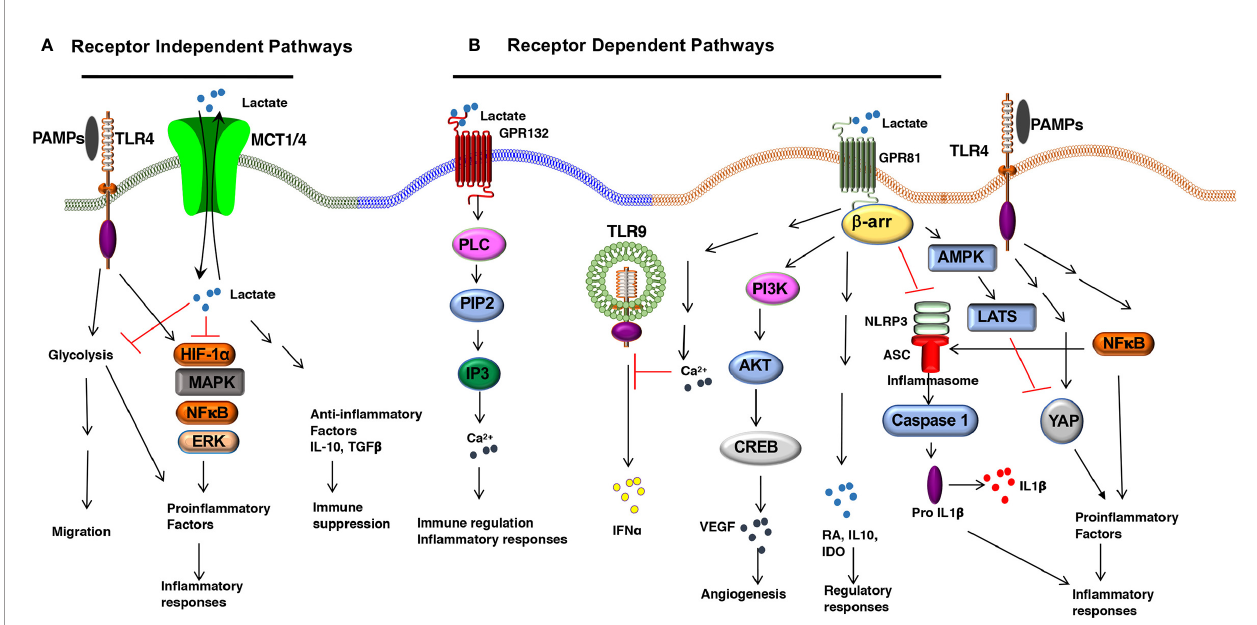
FIGURE 1 | The Lactate-mediated receptor-dependent and receptor-independent signaling pathways. Lactate binds to GPR81 and GPR132 receptors and activates several downstream signaling pathways and transcription factors in DCs and macrophages. (A) Lactate binding to GPR81 and GPR132 results in the activation or suppression of several downstream pathways such as PI3K/AKT/CREB, PLC/IP3/Ca 2+ , b -arrestin/in fl ammasome, AMPK/LATS/YAP/NF- k B. This results in reduced expression of proin fl ammatory cytokine production and increased expression of immune regulatory factors (IL-10, IDO, RA, TGF b ) in response to TLR ligands. (B) Lactate can shape APC functions independent of surface receptors. MCTs transport extracellular lactate into the cells, and intracellular lactate can modulate APC functions by directly regulating the activation of multiple signaling pathways and transcription factors such as HIF-1 a , MAPK, ERK, and NF- k